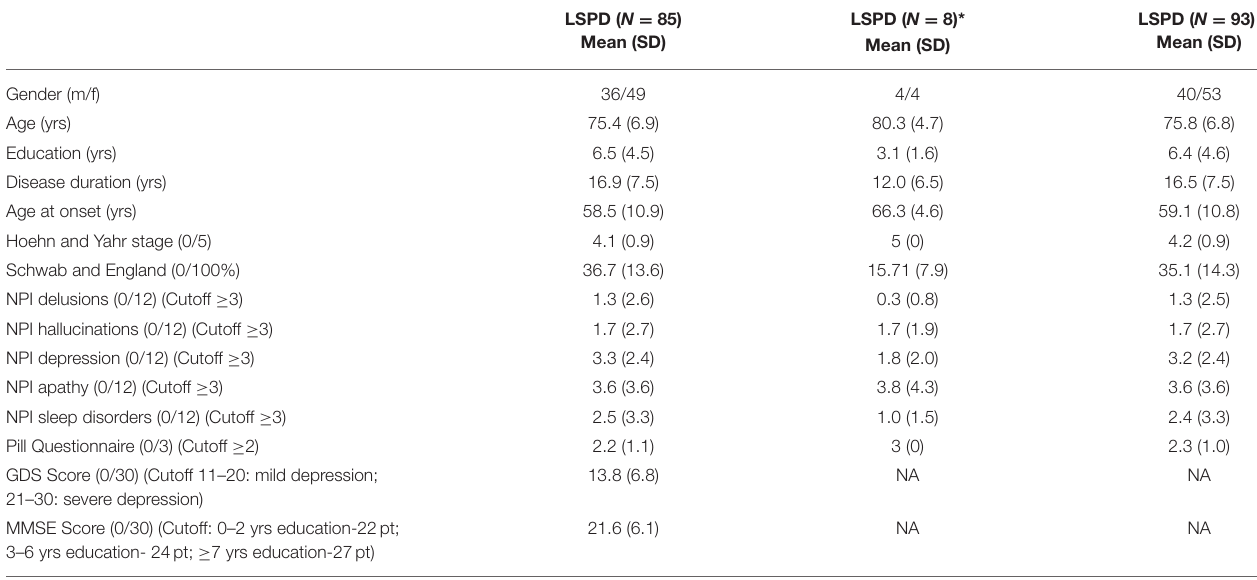
TABLE 2 | Demographic and clinical characteristics of LSPD